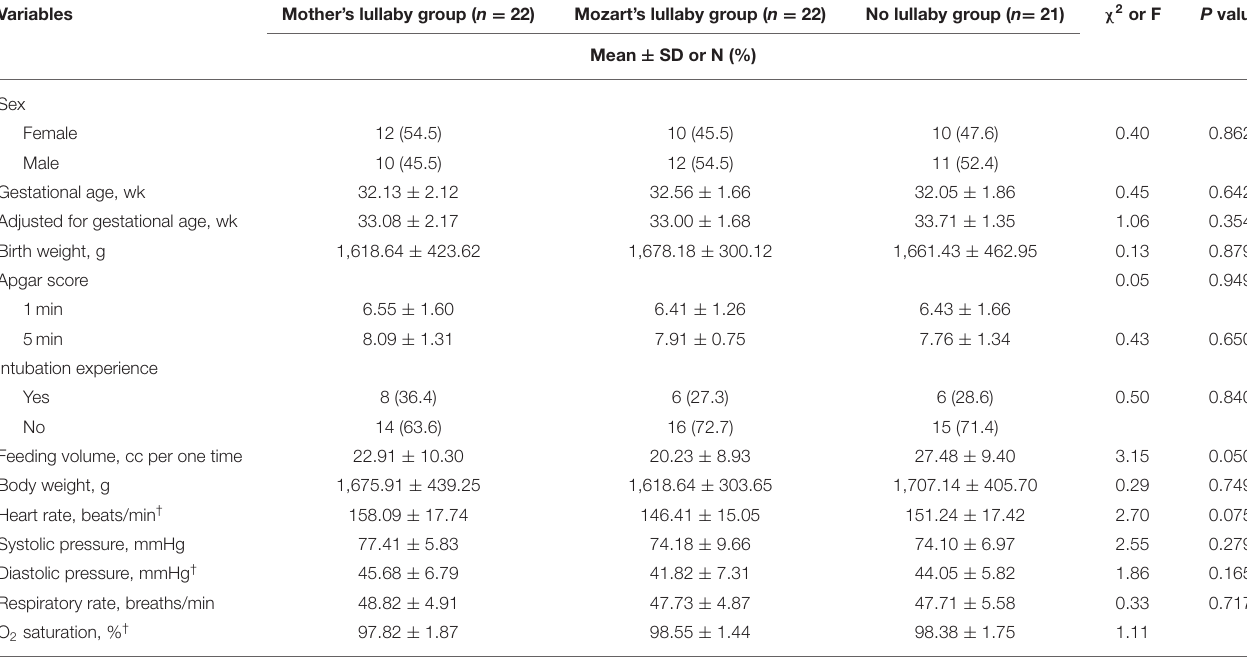
TABLE 1 | Homogeneity test for participant’s characteristics between groups ( N = 65).